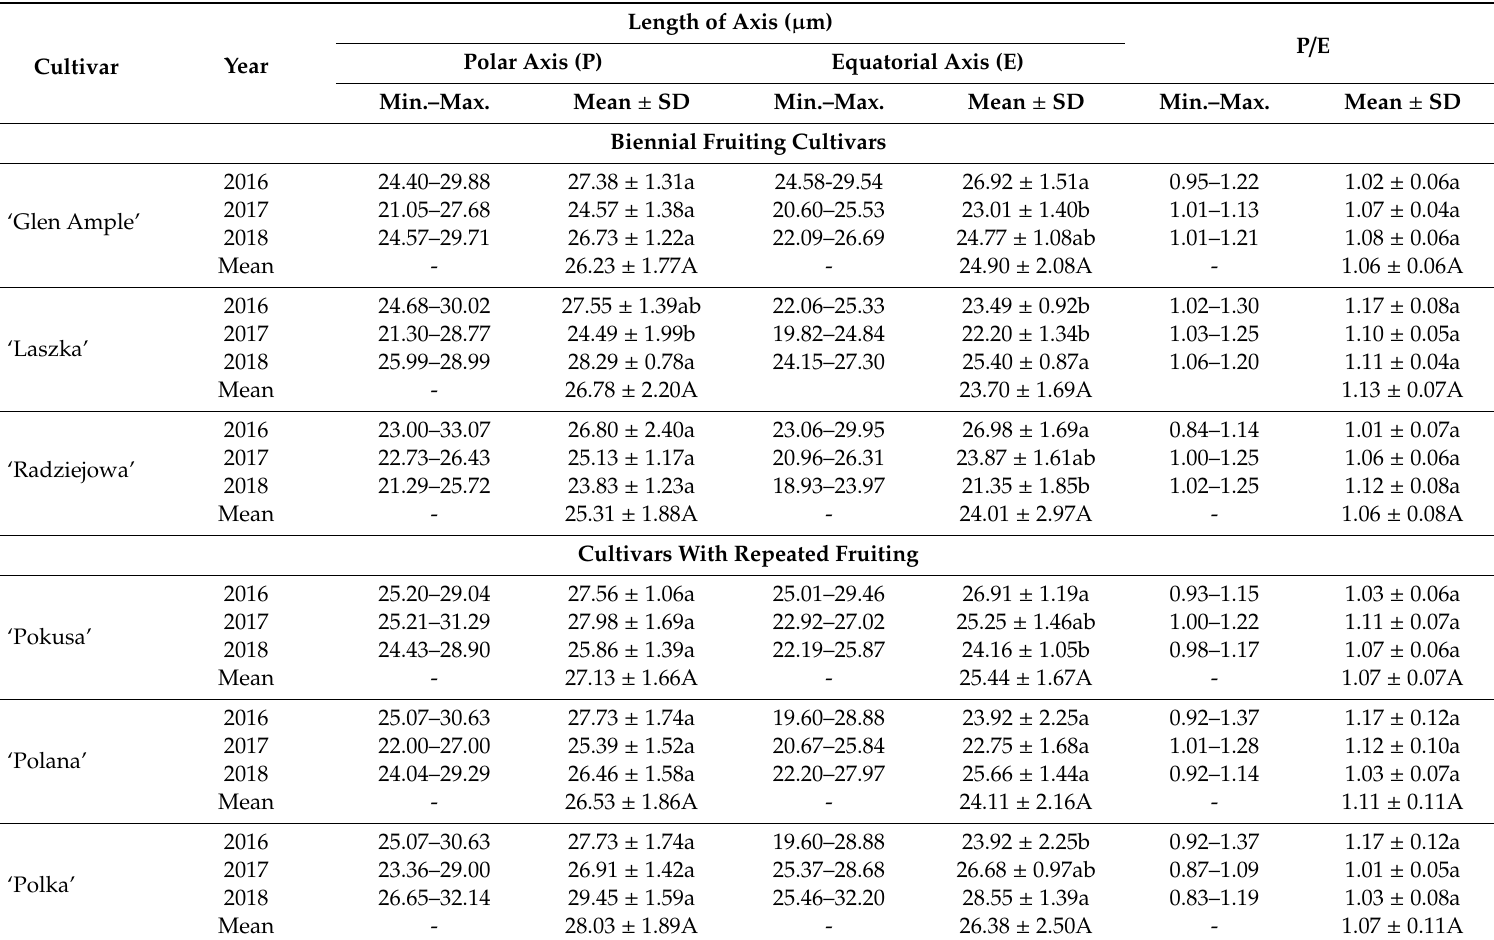
Table 1. Length of polar and equatorial axes and the shape index of pollen grains of R. idaeus cultivars.